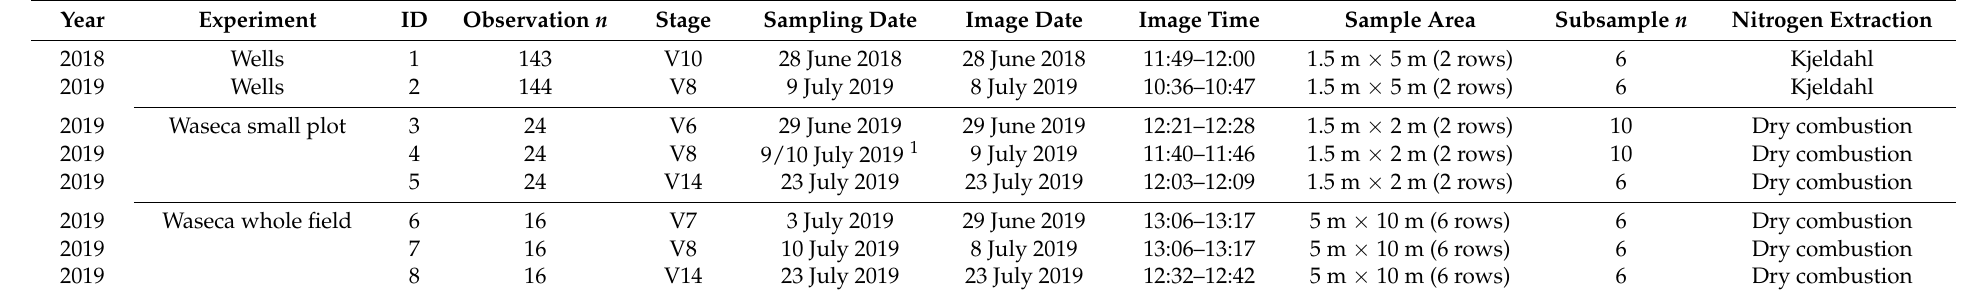
Table A1. Number of experimental observations ( n ), tissue-sampling date, image-acquisition date and local time, sampling area, number of tissue subsamples, and nitrogen extraction method for each experimental data subset by vegetative development